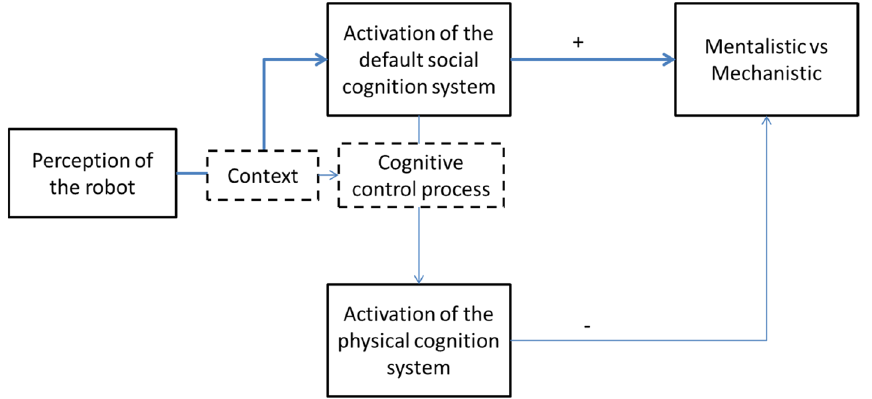
Figure 2. From the social and physical cognition system to mentalistic vs mechanistic representation of a robot’s